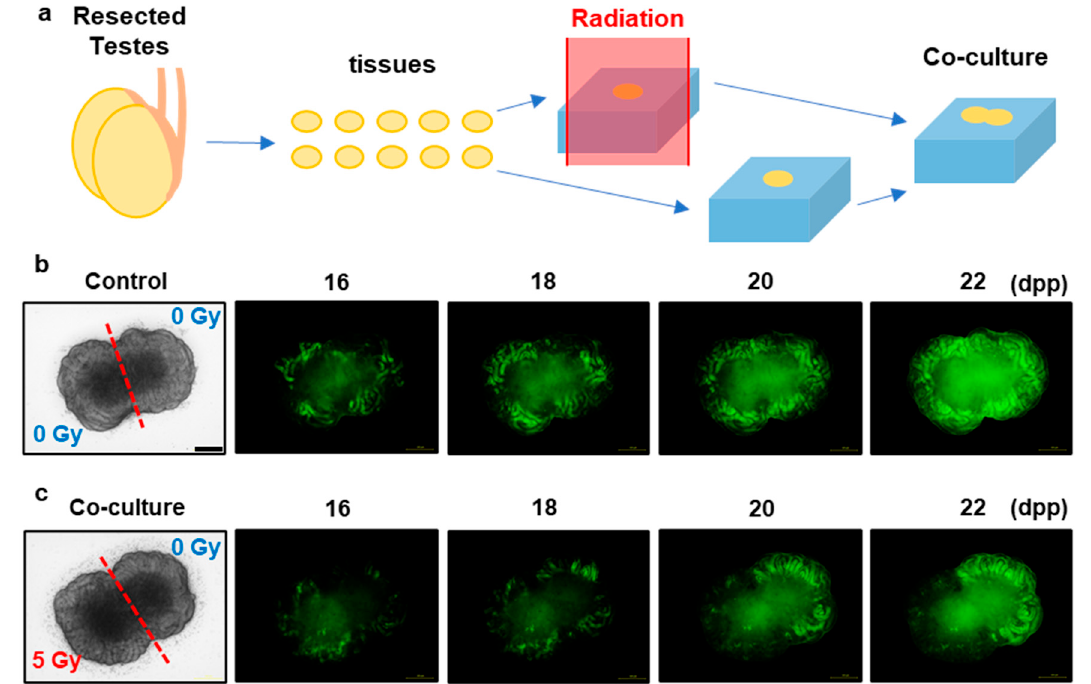
Figure 5. X-ray-induced effects on spermatogenesis in co-cultured and jointed tissue culture. ( a ) Schematic representation of the co-cultured and jointed tissue culture. The two testicular tissue samples were obtained from the same Acr-GFP transgenic mouse. One of these was exposed to 0 Gy (control) ( b ), and the other was exposed to 5 Gy X-rays ( c ). Representative images show Acr-GFP expression in the co-cultured and jointed tissue cultures from 16 to 22 dpp. The areas expressing Acr-GFP did not expand from the non-irradiated to the irradiated areas, although the central area of the co-cultured tissue showed autofluorescence. Therefore, the survival of spermatogonial cells in the non-irradiated areas and migration of these cells via the seminiferous tubules were essential for the TSE because the co-cultured and adjoined tissues had no individual seminiferous tubules connecting the irradiated and non-irradiated areas. Scale bar, 500 μ m.